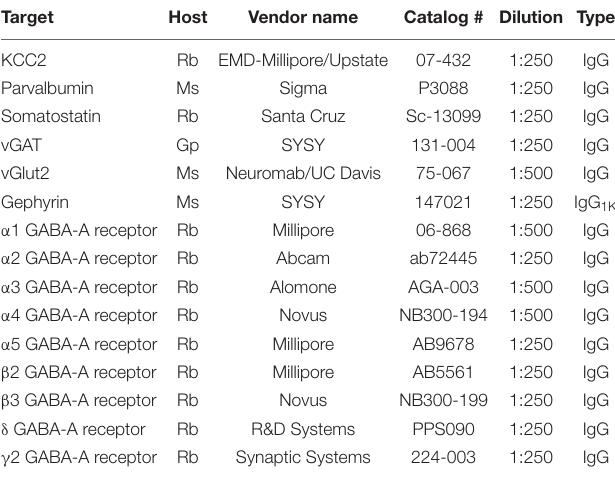
TABLE 1 | List of primary antibodies